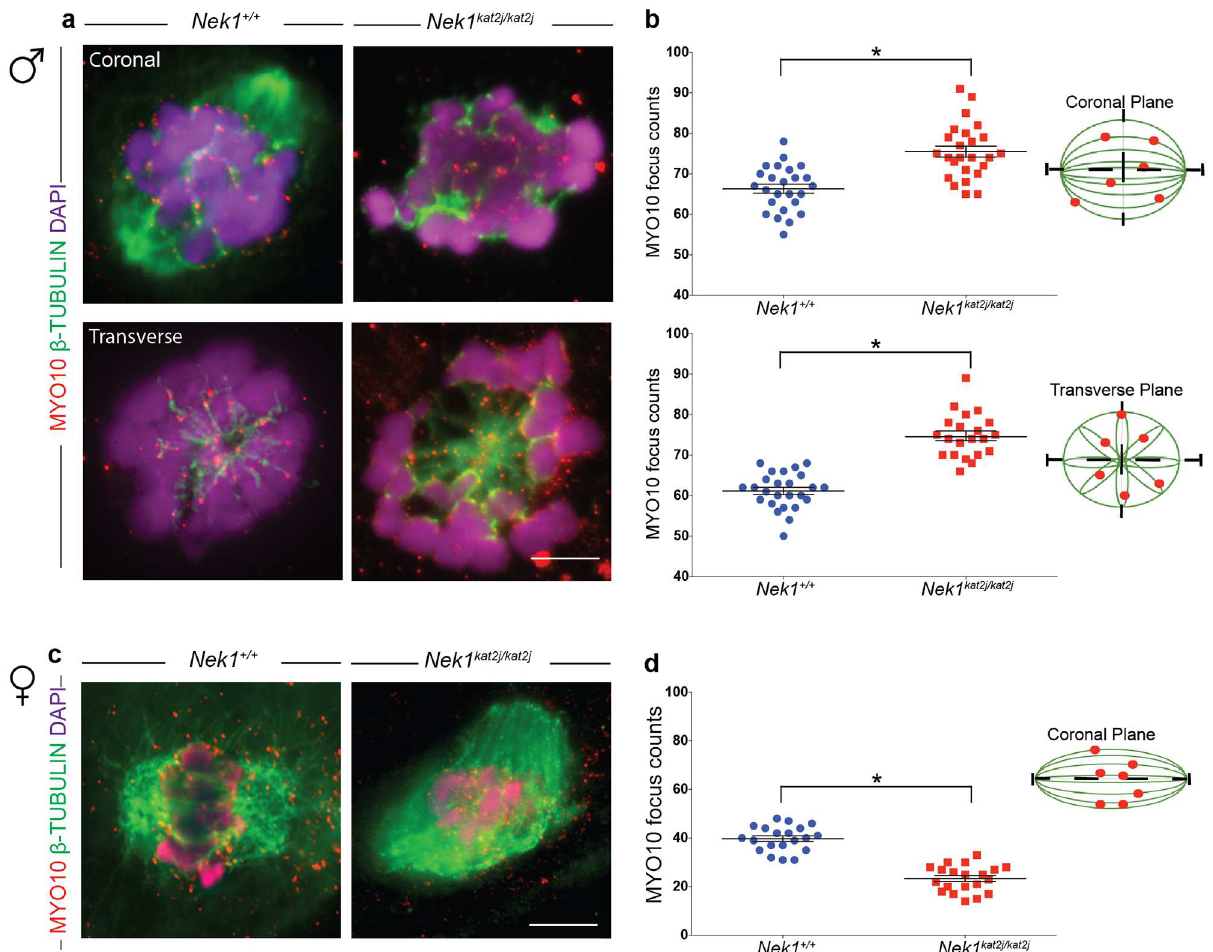
Fig 4. Nek1 kat2j/kat2j spermatocytes and oocytes show aberrantlocalization of myosin X (MYO10) on meiosis I spindles. (a) IF against MYO10 (red), β -tubulin(green)and DAPI (magenta) on spermatocytes from wildtype(left) and Nek1 kat2j/kat2j mice (right) in coronal (top) and transverse (bottom) planes.Arrowheadsindicateexamplesof MYO10 foci. Quantitation of MYO10 focus counts per nucleusare given in panel (b). (c) IF againstMYO10 (red), β -tubulin(green) and DAPI (magenta) in oocytes of both wildtypeand mutant mice. Arrowheadsindicateexamplesof MYO10 foci. Quantitation of MYO10 focus counts per nucleusare given in panel (d). All values are focus counts per spindleand black bars denote means ± Standarddeviation. * Indicatesstatistically significantdifferences (Unpaired t test p <